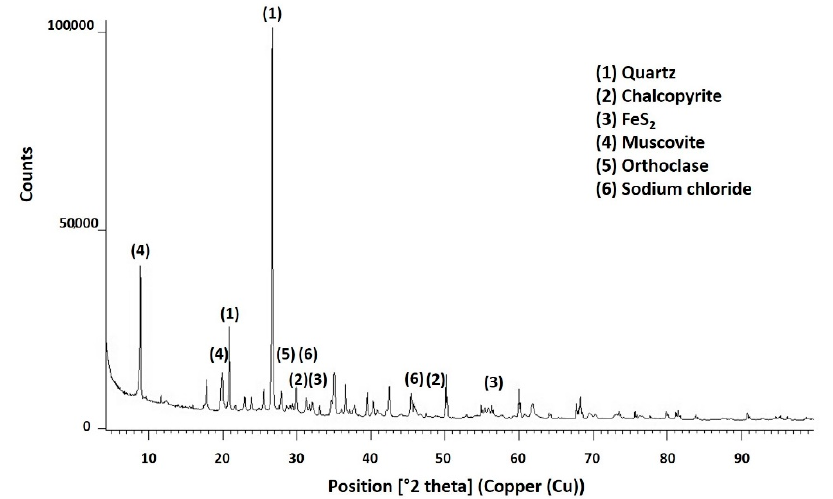
Figure 5. Reflected optical microscope images of the pretreatment products at a magnification of × 50 ( a , b ). Chalcopyrite identified in ( a , b ) as (1).